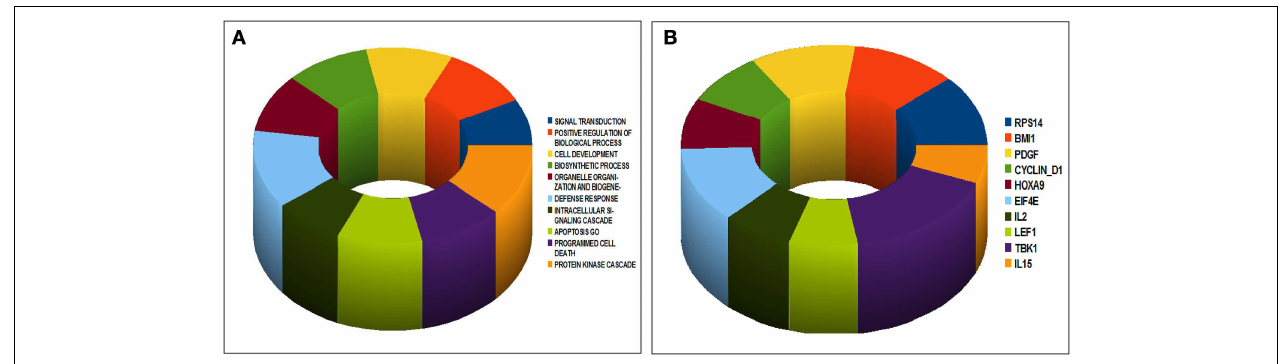
FIGURE 2 | Gene Set Enrichment Analysis of the differentially expressed genes in ID-BL samples according to the presence of EBV. The set of the differentiating genes significantly enriched in well recognized Gene Ontology Biological Processes (A) or Oncogenic Signatures related to known oncogenes (B) .